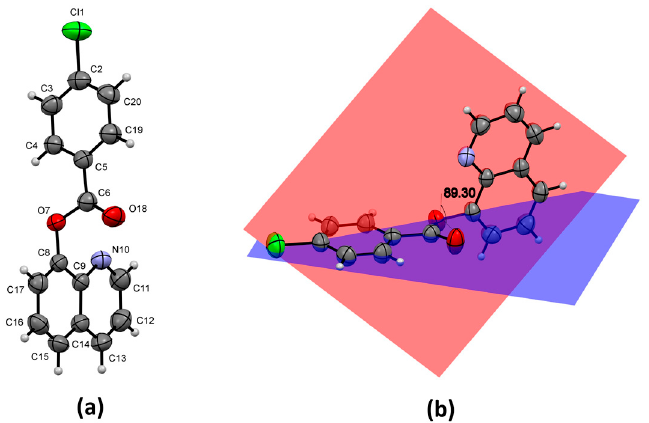
Figure 5. ( a ) Molecular structure of 3 with anisotropic thermal vibration ellipsoids drawn at the 50% probability level. ( b ) Dihedral angle between planar fragments in the molecule is shown.